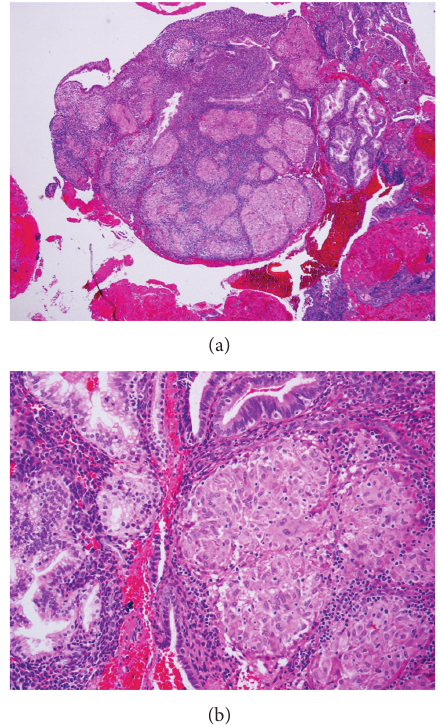
Figure 2: (a) Hematoxylin and eosin (H&E) stain at low mag- nification shows noncaseating granulomas. (b) H&E stain at high magnification shows a follicular pattern of granulomas, asteroid bodies, and the absence of